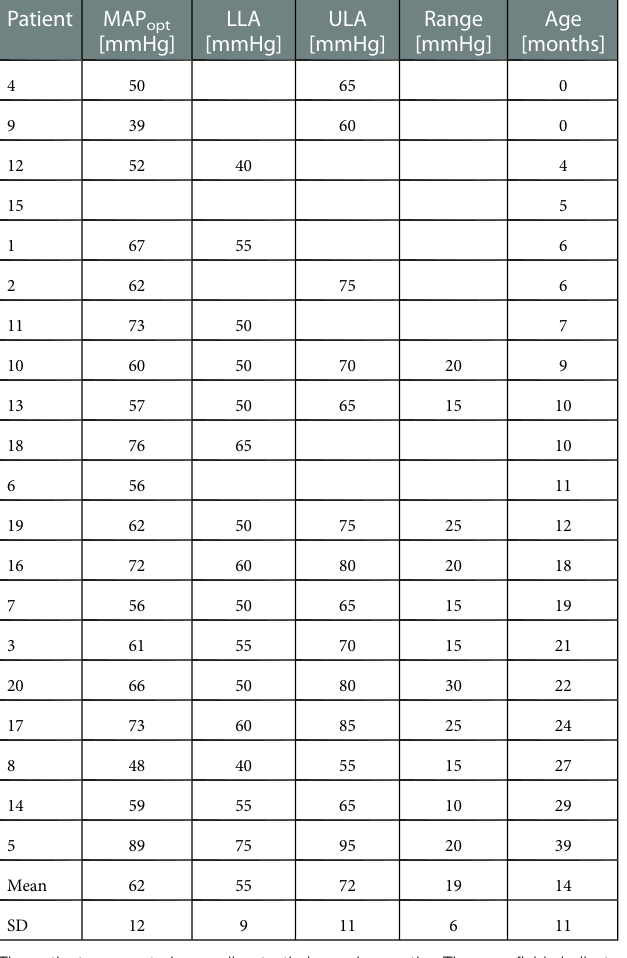
The patients are sorted according to their age in months. The gray fi elds indicate unobtainable values. ULA, upper limit of autoregulation; LLA, lower limit of autoregulation. The range is the difference between ULA and LLA. The units are indicated in [ ].